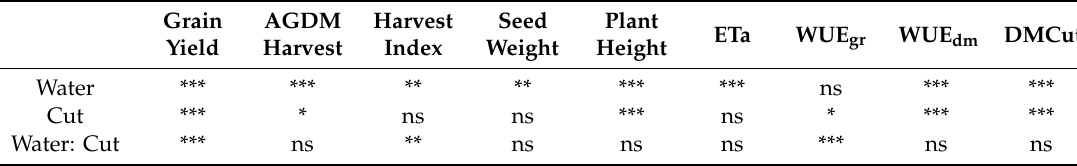
Table 4. Significance and interaction e ff ect.